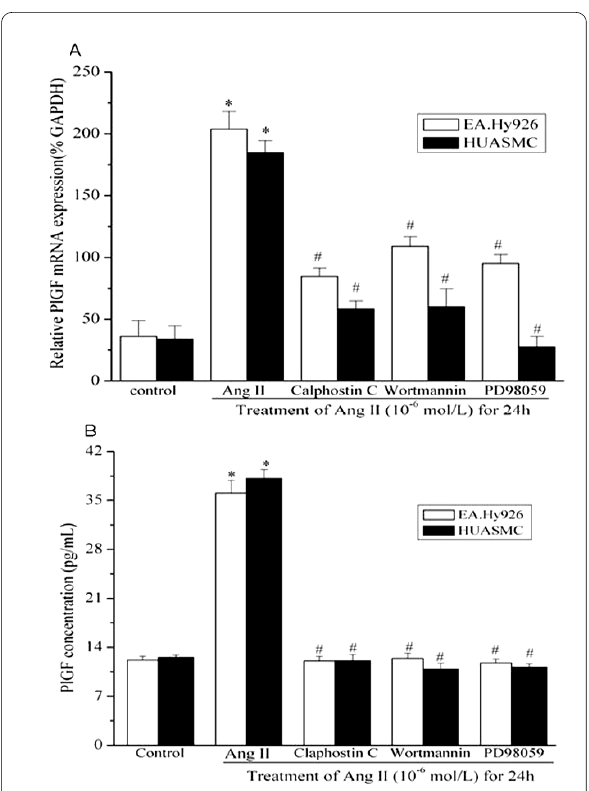
Figure 5 PlGF and VEGF is involved in Angiotensin II-induced proliferation of cultured EA.Hy 926 cells and HUASMCs . Quiescent cells were treated with Ang II (10 -6 mol/L), Ang II (10 -6 mol/L) and Losar- tan (10 -6 mol/L), Ang II (10 -6 mol/L) and the specific neutralizing anti- body to PlGF (A) or VEGF (B) (20 μg/mL) for 24 hours, followed by the assessment of cell proliferation by MTT assay. Each value is the mean ± SD of 5 separate determinations. * indicates P < 0.05 vs control cells. # indicates P < 0.05 vs cells treated with Ang II. Ab-PlGF: the specific neu- tralizing antibody against PlGF. Ab-VEGF: the blocking antibody to